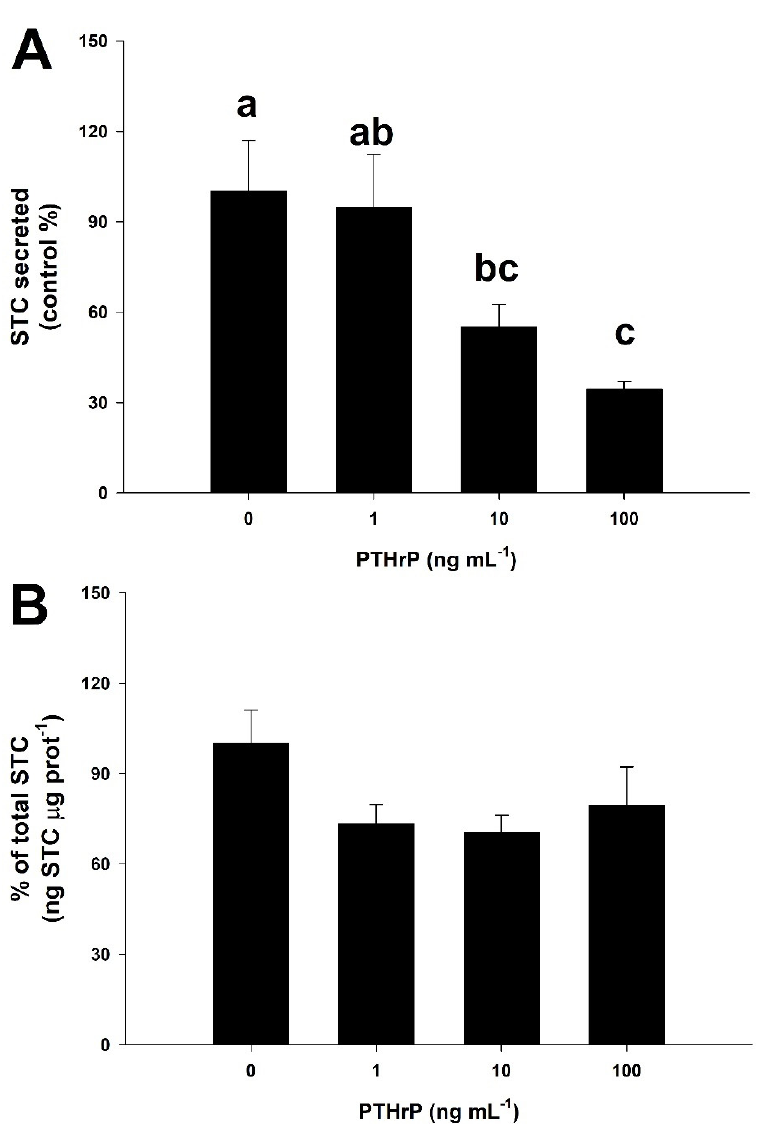
Figure 5. Dose-response effects of PTHrP on STC ex vivo secretion ( A ) and production ( B ) from the corpuscles of Stannius of the gilthead seabream at normal (1.46 mM Ca 2+ ) calcium concentration. Basal STC secretion for the 0 ng PTHrP mL − 1 group is 0.37 ± 0.06 ng STC μ g prot − 1 h − 1 ( n = 6). Values are presented as % of the control group for single independent experiments (mean ± SEM, n = 6 per group). Different letters indicate significant differences between groups (one-way ANOVA followed by a Tukey ´ s post-hoc test, p <